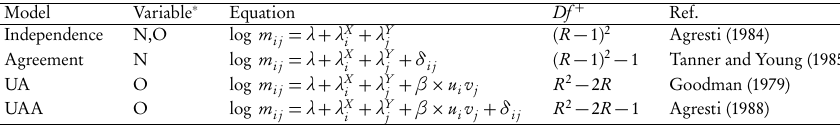
Log-linear models for R × R contingency